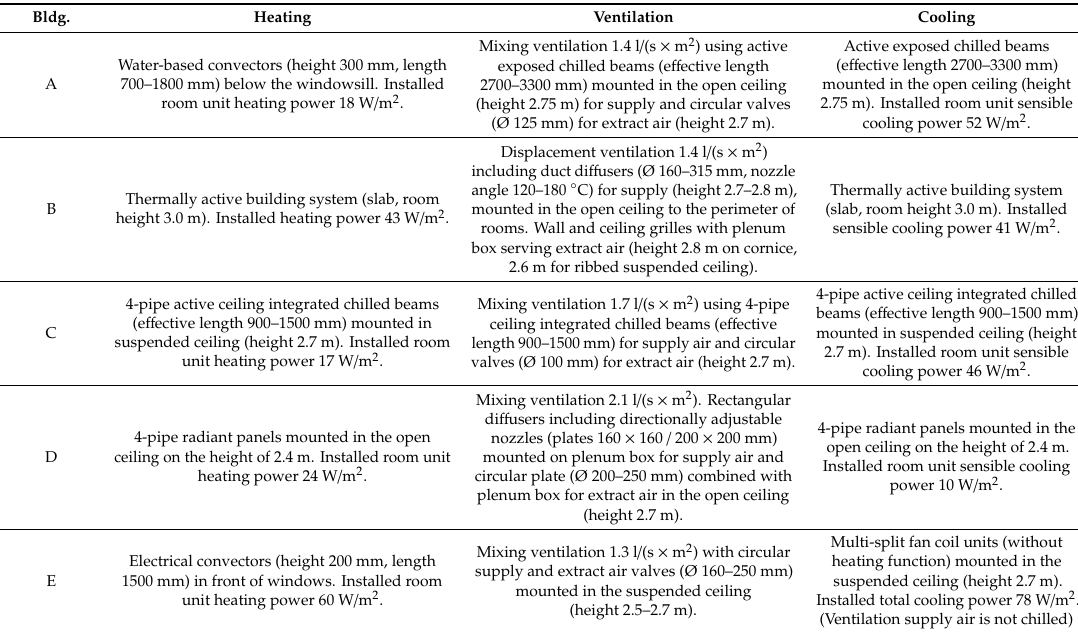
Table 2. Heating, ventilation, and air conditioning room design solutions of reference